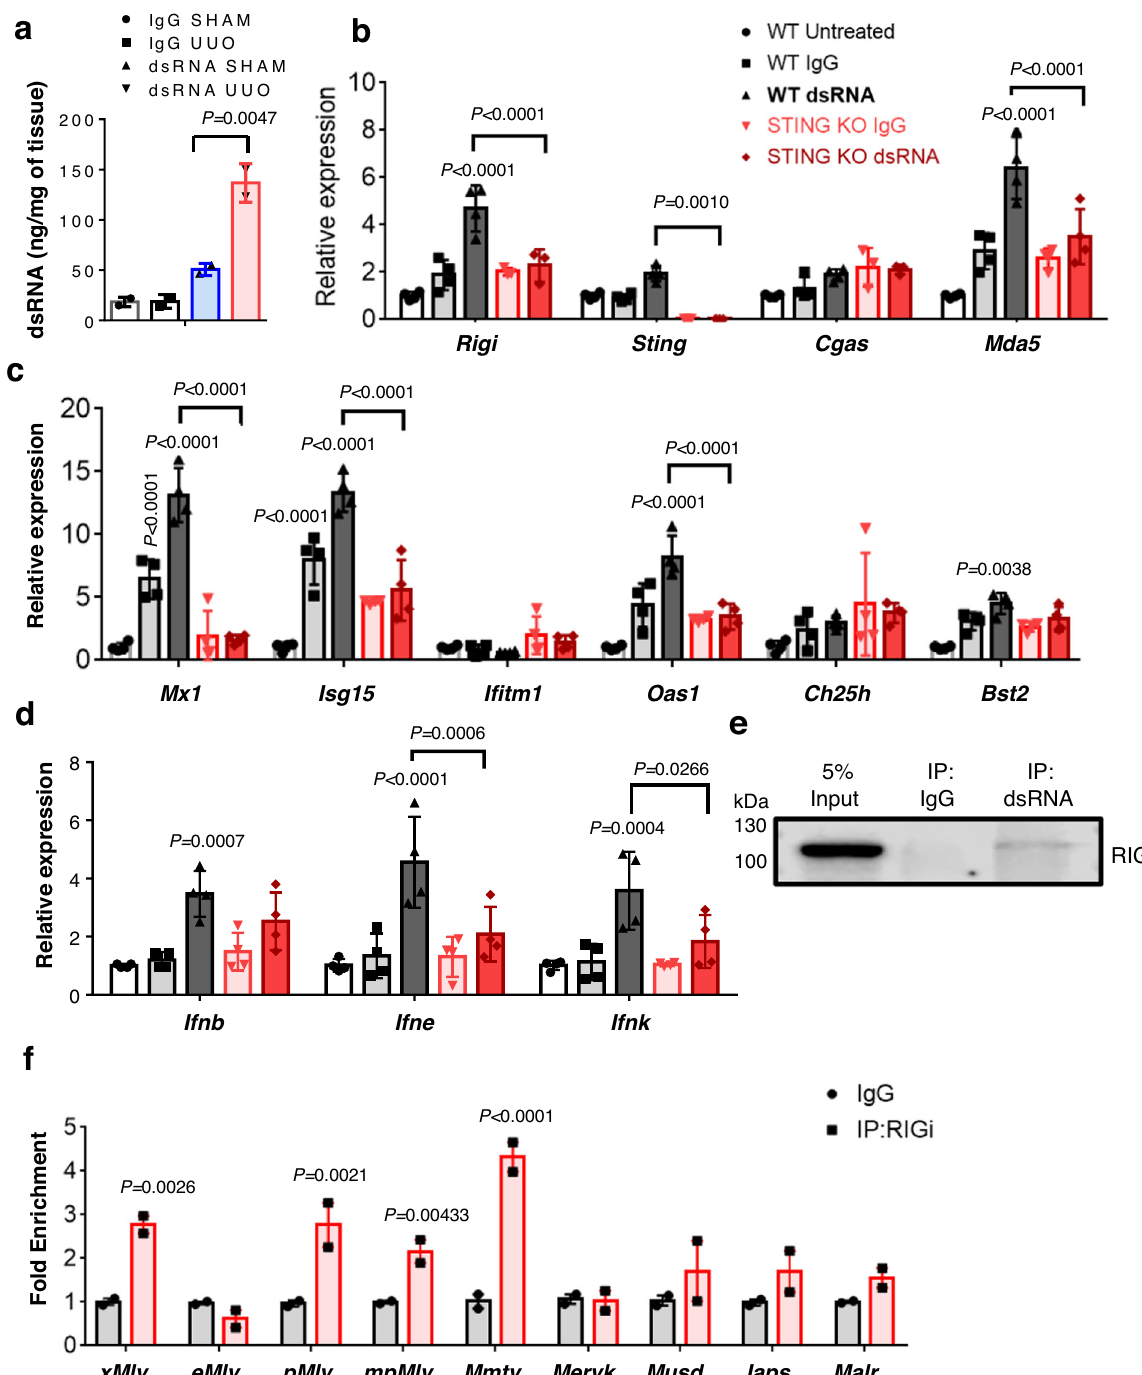
Fig. 4 | Increased dsRNA content in UUO mice kidneys elicits innate immune response via RIG-I. a dsRNA content in SHAM and UUO mice kidneys. Data were representative of two independent experiments (IgG, Black; dsRNA SHAM, blue; dsRNAUUO,red). b RelativemRNAlevelsofcytoplasmicnucleicacidsensors( Rigi, Sting, Cgas , and Mda5 ) in WT and STING KO PTECs untreated or transfected with immunoprecipitated RNA using IgG or dsRNA antibody ( n =4 in each). c Relative mRNA levels of ISGs ( Mx1, Isg15,I fi tm1, Oas1, Ch25h , and Bst2 ) in WT and STING KO PTECs transfected with immunoprecipitated RNA using IgG or dsRNA antibody ( n =4 in each). d Ifnb, Ifne , and Ifnk RNA levels in WT (untreated, white; IgG, gray; dsRNA, black) and STING KO (IgG, pink; dsRNA, red) PTECs transfected with immunoprecipitated RNA using IgG or dsRNA antibody ( n =4 in each). e CO-IP